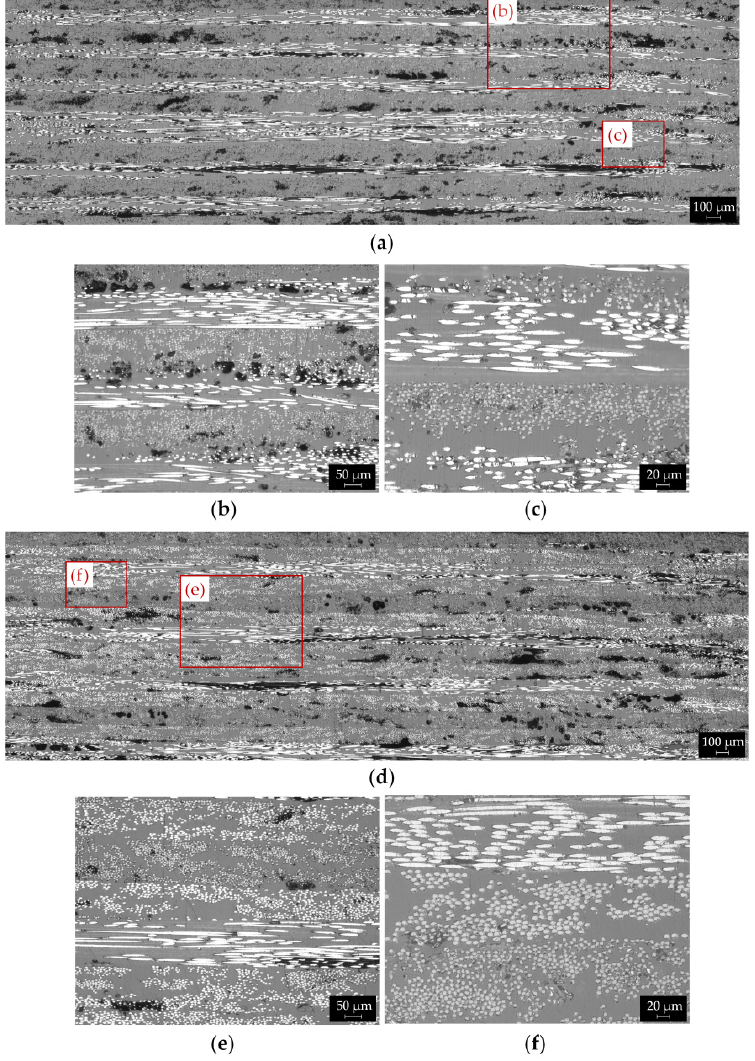
Figure 7. Optical micrographs showing typical YZ cross sections of ( a ) [0/90] s and ( d ) quasi isotropic [0/45/90/ − 45] s printed samples; magnified images in areas between stacked layers for ( b ) [0/90] s and ( e ) [0/45/90/ − 45] s parts highlighting interlayer voids and laminate layup sequence; magnified images in areas inside the printed beads for ( c ) [0/90] s and ( f ) [0/45/90/ − 45] s samples revealing uneven fibers distribution and matrix-rich areas.